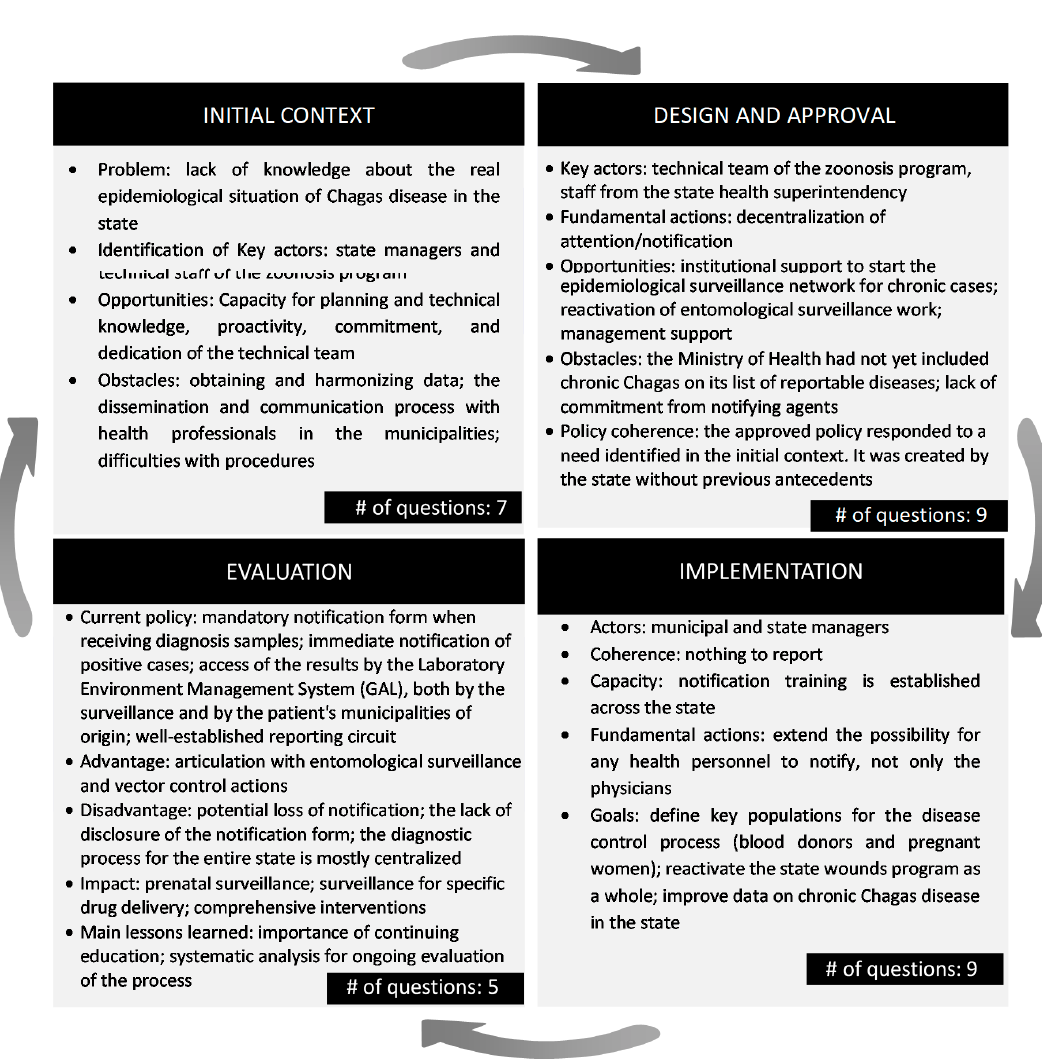
Figure 1. Main information axes for interviews on notification of chronic Chagas disease in Goiás.